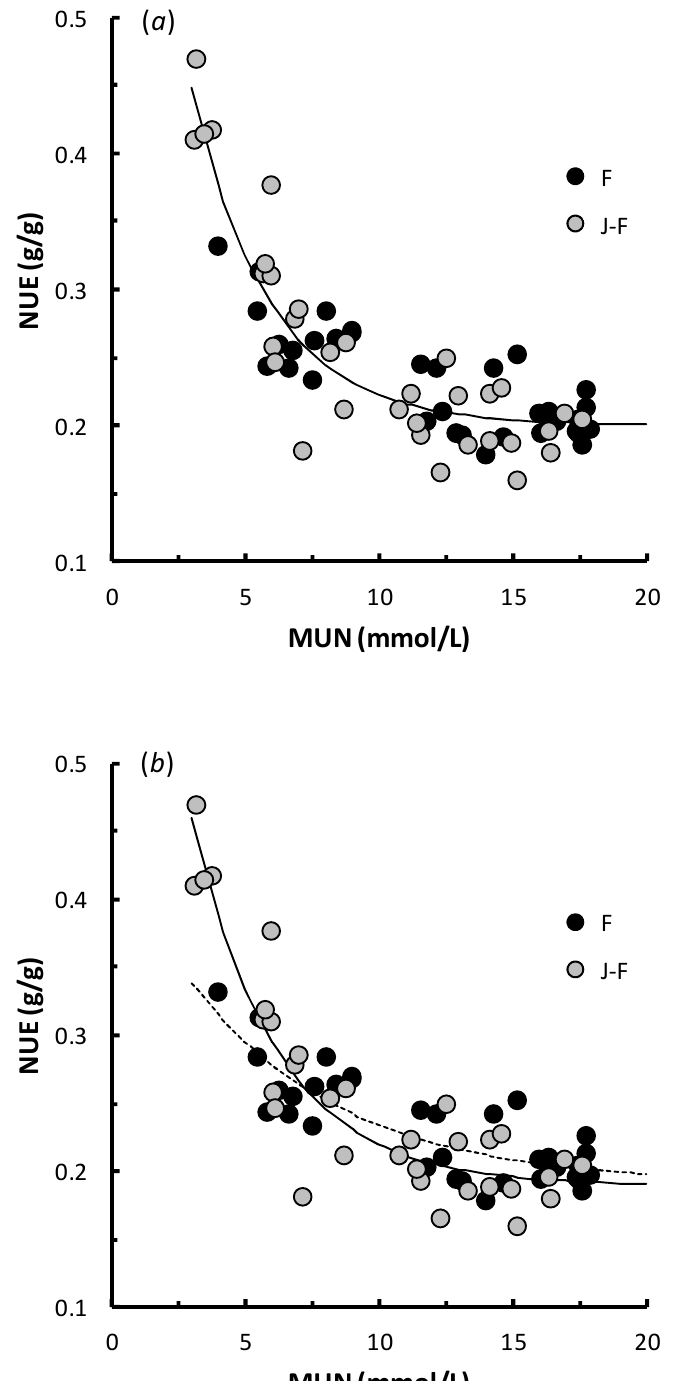
Figure 3. Asymptotic relationships between NUE and MUN for groups of ryegrass-fed Friesian (N = 35) and Jersey × Friesian (N = 33) cows: ( a ) shows the overall line of best fit (Model 10; Table 6) and ( b ) shows separate regression models for both breeds (Models 11 and 12; Table